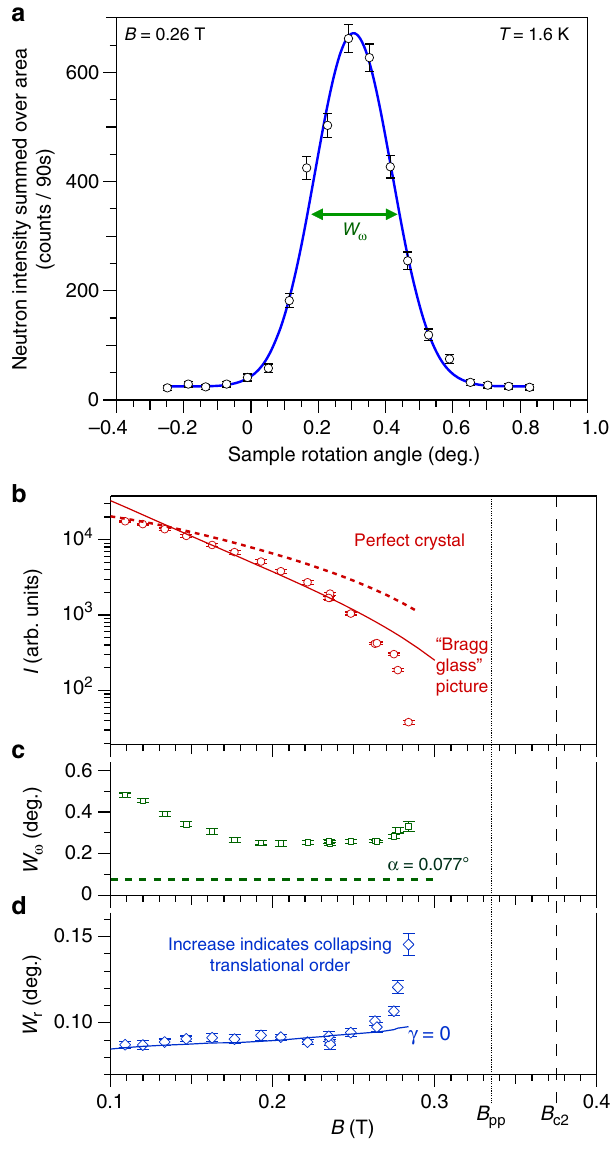
p ffiffiffiffiffiffiffiffiffiffiffiffiffi . Approximate c 44 = c 66